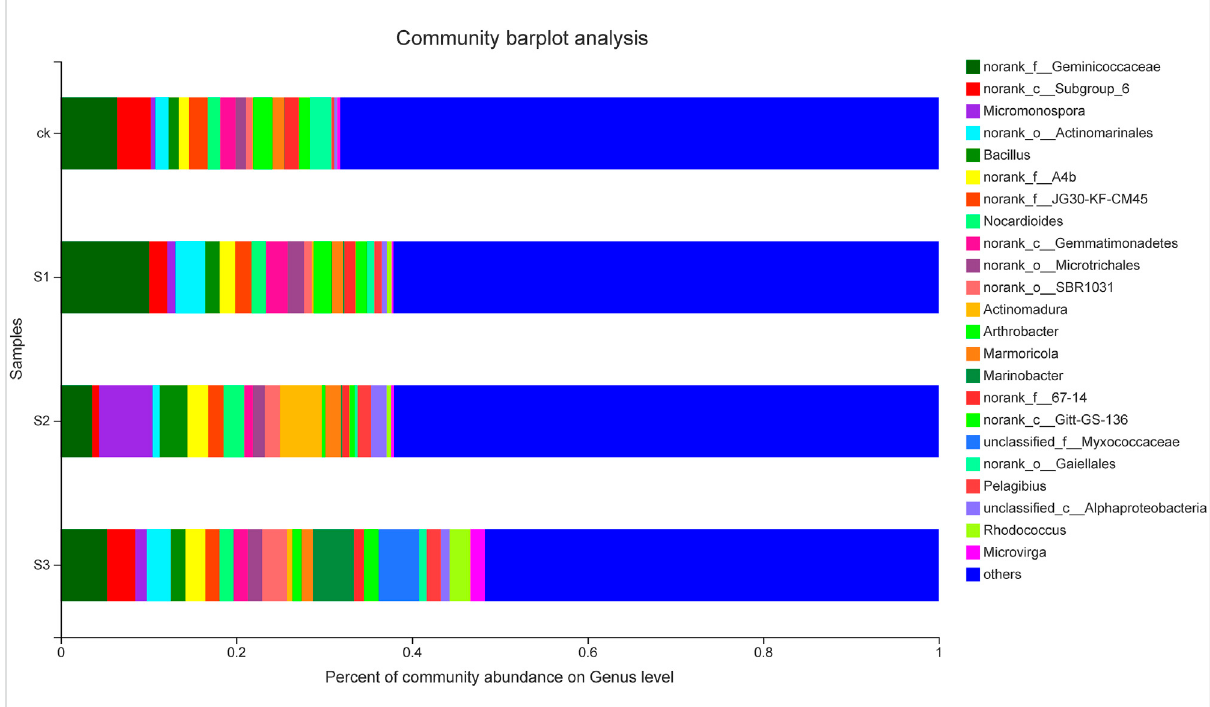
FIGURE 5 Relative abundance of the predominant genera (top 40) in each sample. Taxa with an abundance < 0.01 are included in “ others. ” The x -axis represents the relative abundance of all communities, and the y -axis represents different